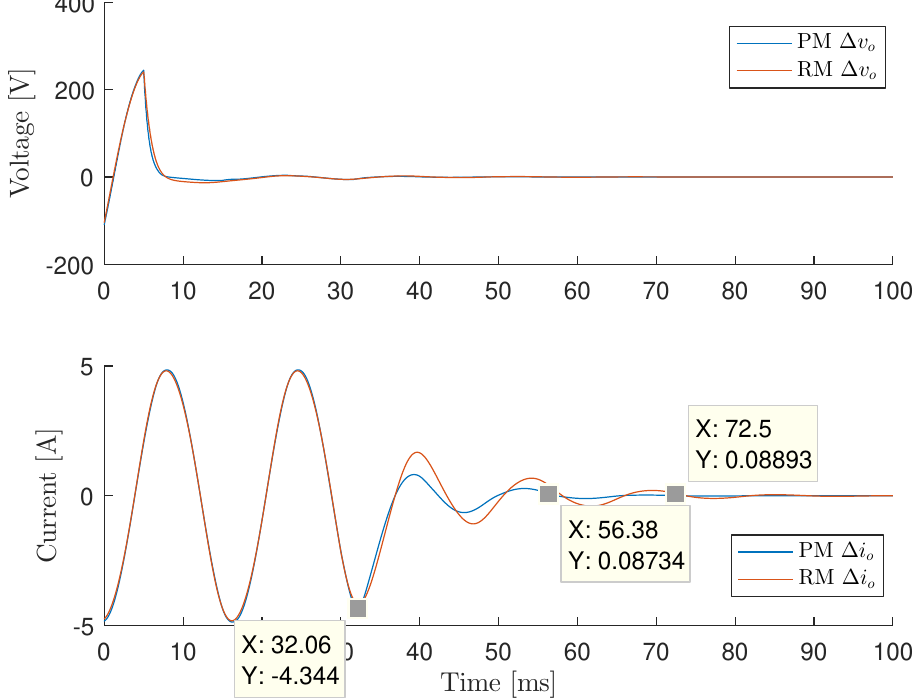
Figure 11. Difference between output voltage and output current of each oscillator with pre-